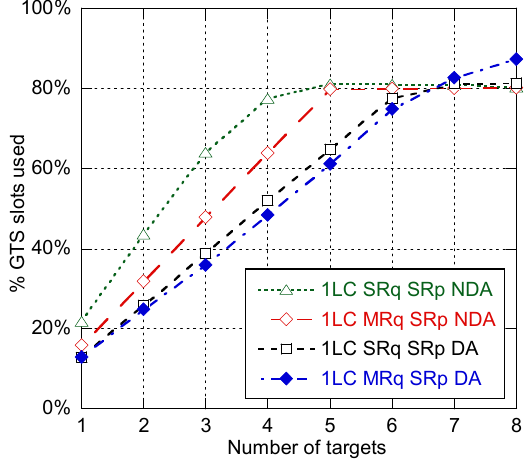
Figure 11. % of GTS slots used for location data transmission for the enhanced